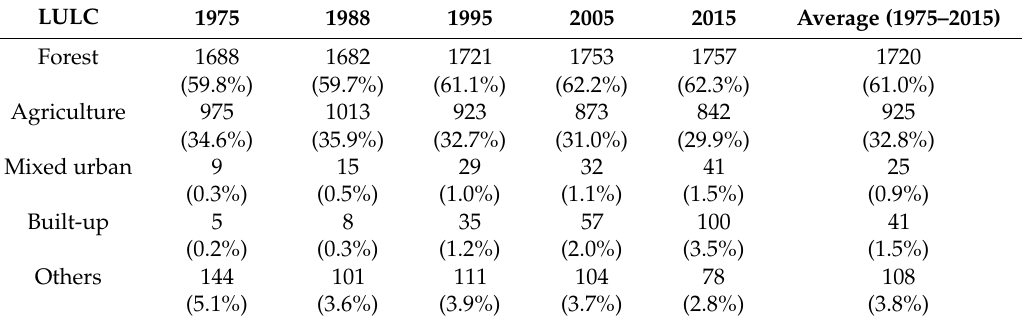
Table 2. LULC in the entire Bagmati catchment between 1975 and 2015 (areas shown in km 2 ).